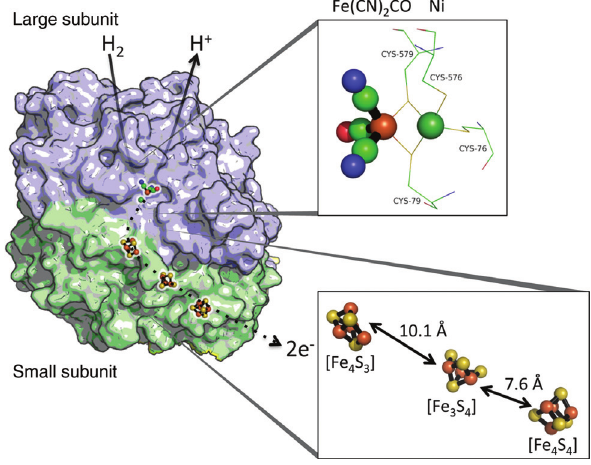
Figure 1 Structure of [NiFe]-hydrogenase 1 from E. coli